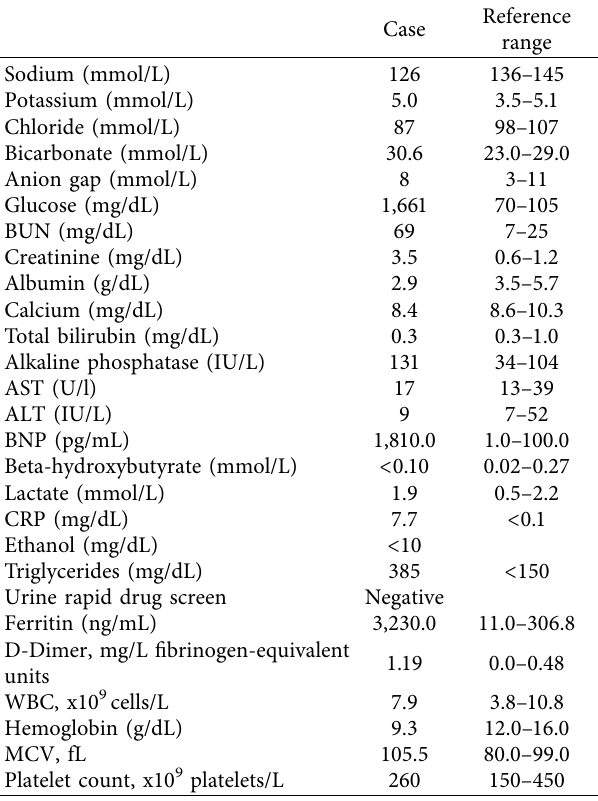
Table 1: Laboratory